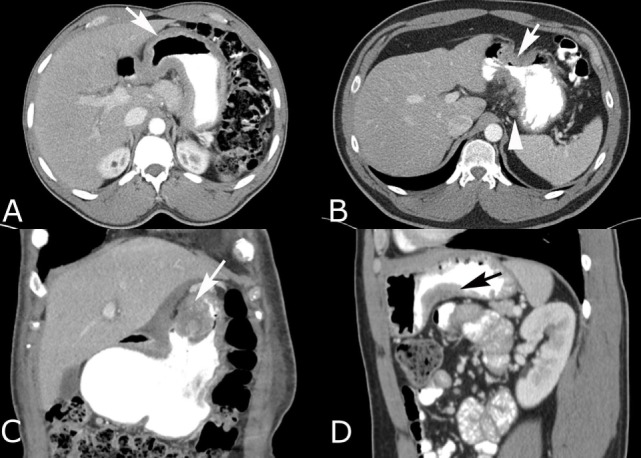
Intravenous and oral contrast-enhanced computed tomography (CT) in four different patients with gastric adenocarcinoma. (A) Diffuse gastric wall thickening with loss of normal rugal fold pattern (arrow). (B) Focal, circumferential narrowing of the antrum with marked wall thickening that has irregular spiculation into the perigastric fat (arrow). Small perigastric lymph node is present (arrowhead). (C) Coronal reconstruction shows an intraluminal polypoid carcinoma (arrow) with heterogeneous enhancement and a soft tissue component that infiltrates the lesser omentum. (D) Sagittal reconstruction shows a carcinoma that is producing focal wall thickening (arrow) along the inferior body of the stomach.